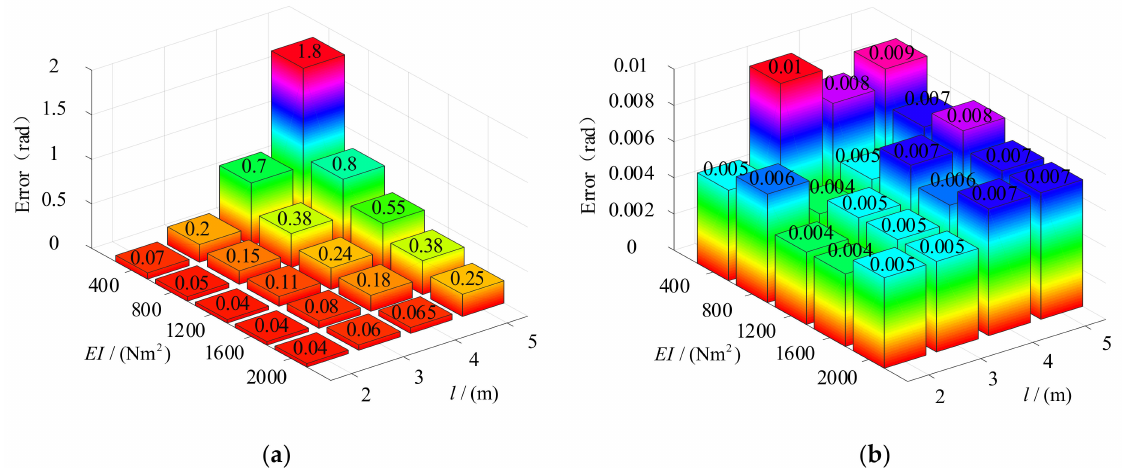
Figure 13. The influence of the length and elastic modulus on error. ( a ) Pole placement strategy. ( b ) Combined control